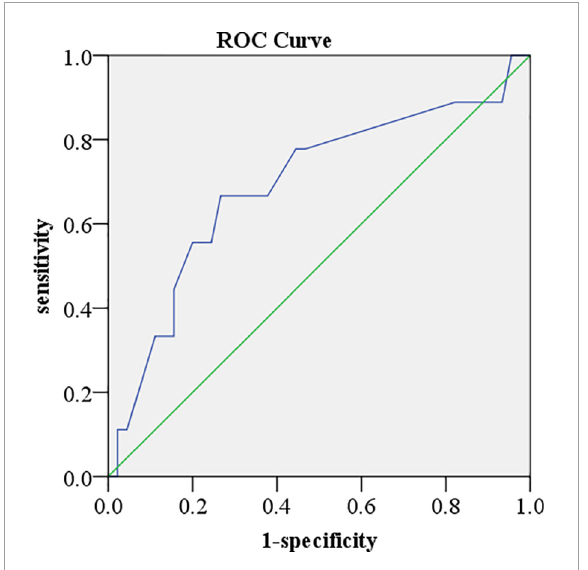
FIGURE3 Receiver operator characteristic curve for analyzing left ventricular global longitudinal peak systolic strain (LVGLS). The area under the receiver operator characteristic (ROC) curve was 0.693. The cutoff value of (cid:49) LVGLS was –13%.